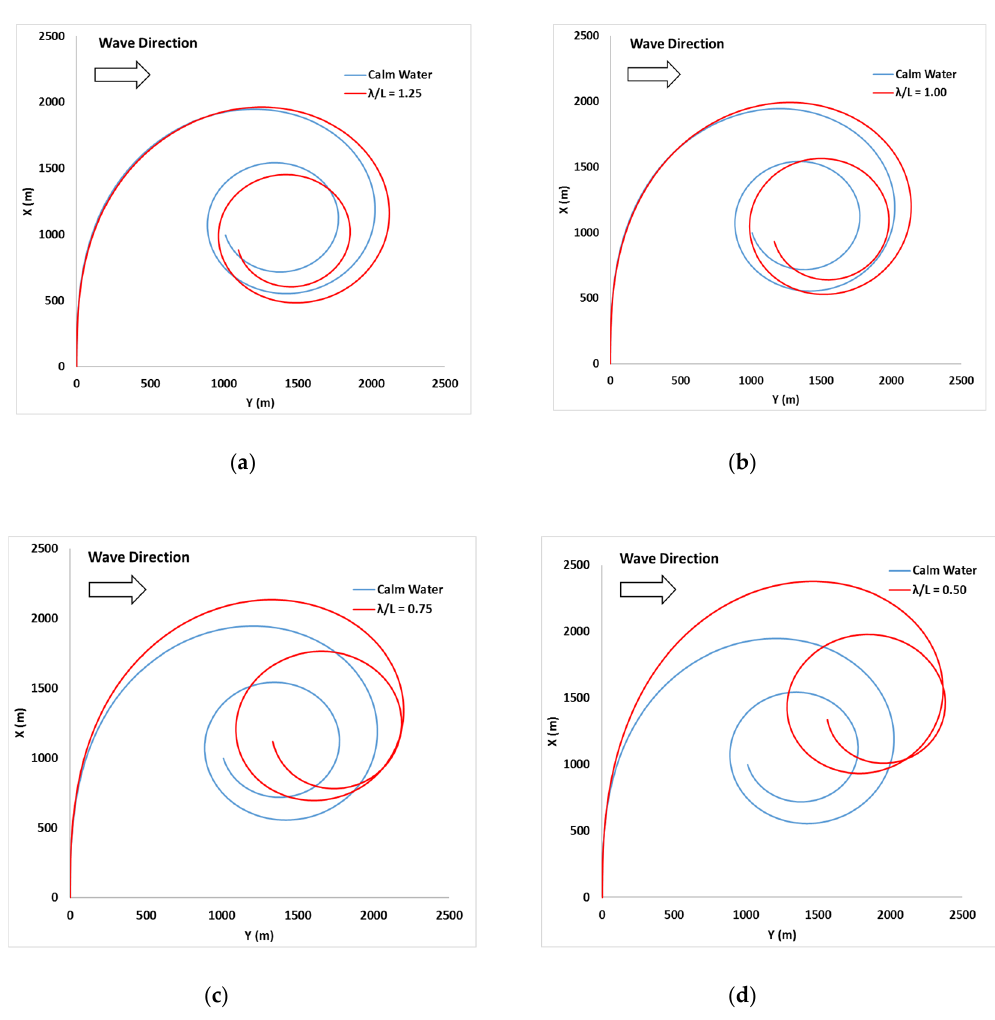
Figure 6. KVLCC’s starboard-side 35 deg turning trajectories in regular waves with 90 deg at t = 0 and four different ratios between wave length and vessel length λ : ( a ) λ = 1.25; ( b ) λ = 1; ( c ) λ = 0.75; ( d ) λ = 0.5.